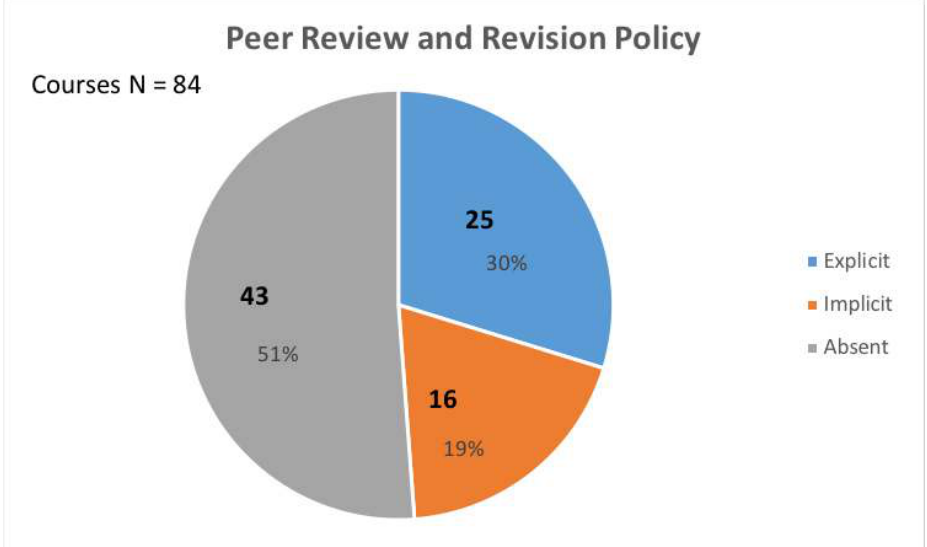
Figure 8: Peer-review and revision